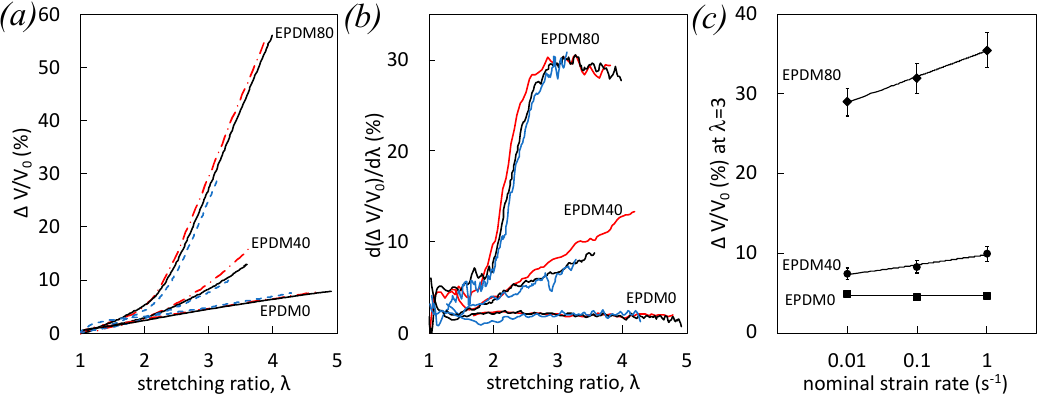
Figure 2. True stress ( a ), tangent modulus ( b ) versus strain for EPDM-0, EPDM-40, and EPDM-80 during single uniaxial loading at the nominal strain rates 10 ⁻ 2 s ⁻ 1 (blue dotted line), 10 ⁻ 1 s ⁻ 1 (black continuous line), and 1 s ⁻ 1 (red dashed dotted line). ( c ) True stress at λ = 3 versus nominal strain rate for EPDM-0, EPDM-40, and EPDM-80.